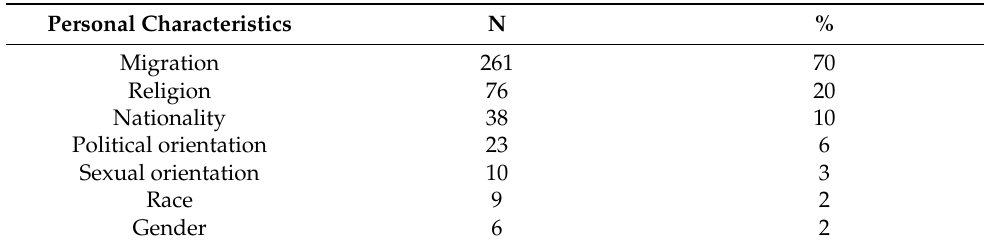
Table 1. Numbers and shares of hate speech statements attacking different personal characteristics (N = 372).